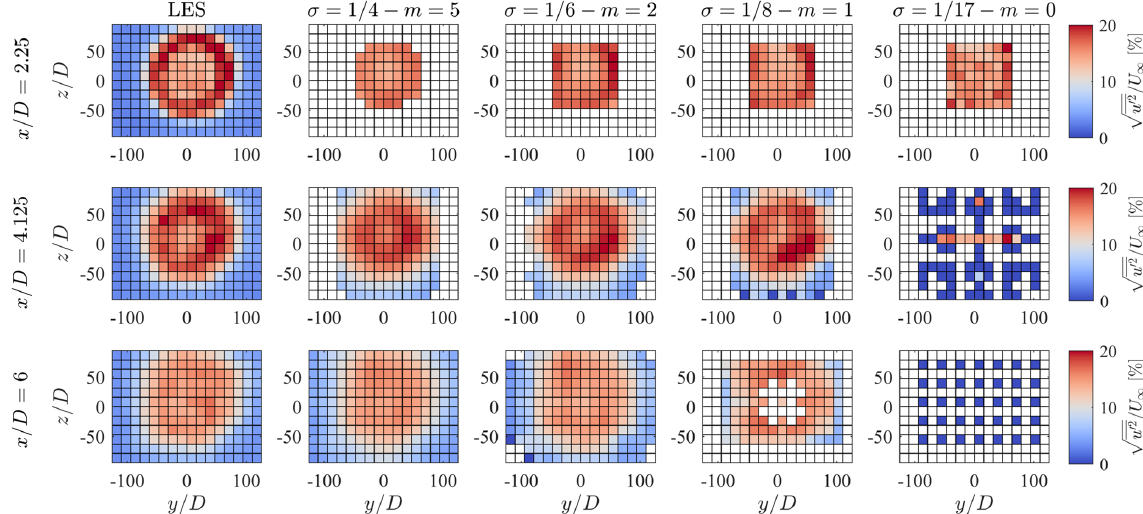
Figure 17. Same as Fig. 16 but for streamwise turbulence